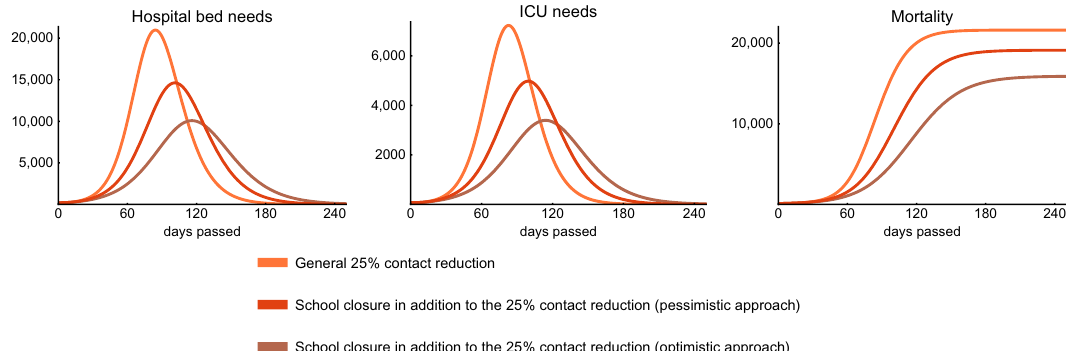
Figure 10. Effect of school closure. Simulations suggest that school closures—if maintained for a long period—effectively decrease peak hospital bed and ICU needs and significantly postpone the peak of the